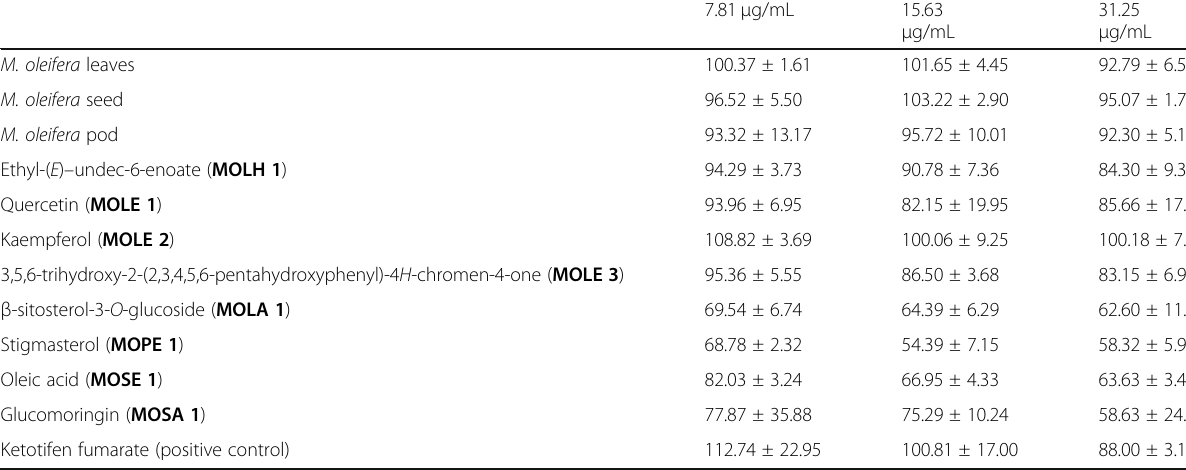
Table 3 Cell viability of crude extracts on RBL-2H3